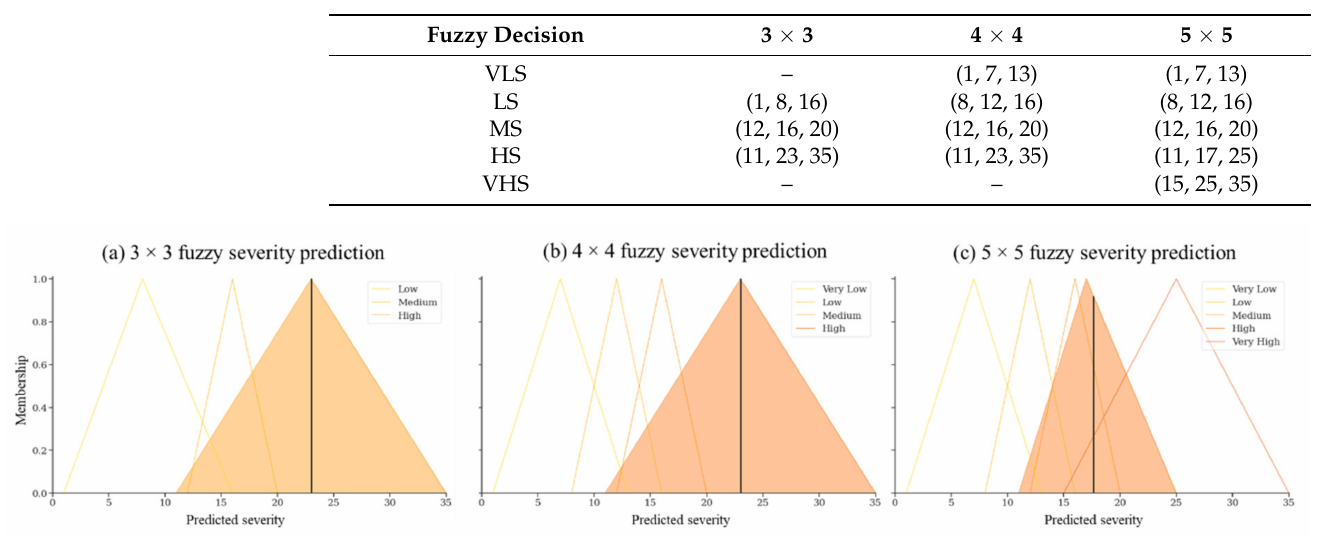
Table 5. Fuzzy membership of severity classes predicted by RMI.